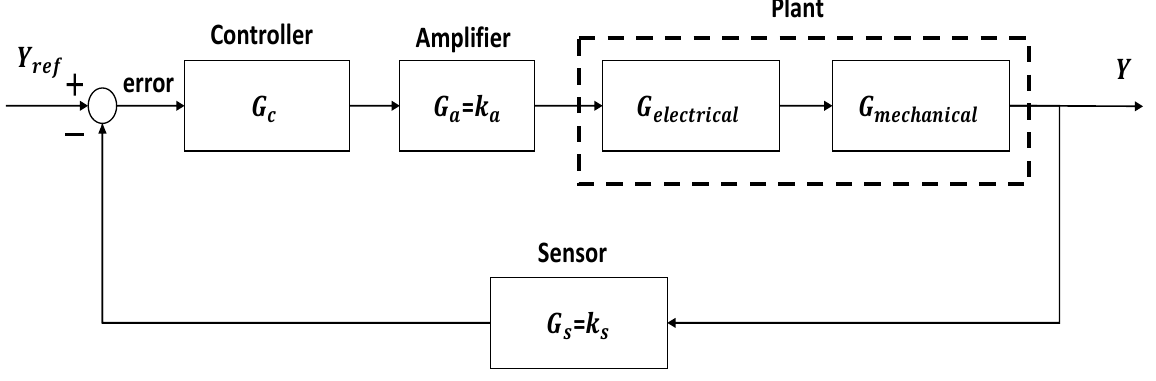
Figure 4. Block diagram representation of closed-loop active magnetic bearing system.